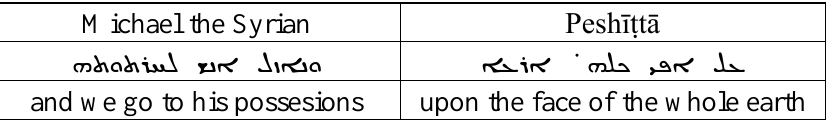
Table 4. Translation disagreement in Gn